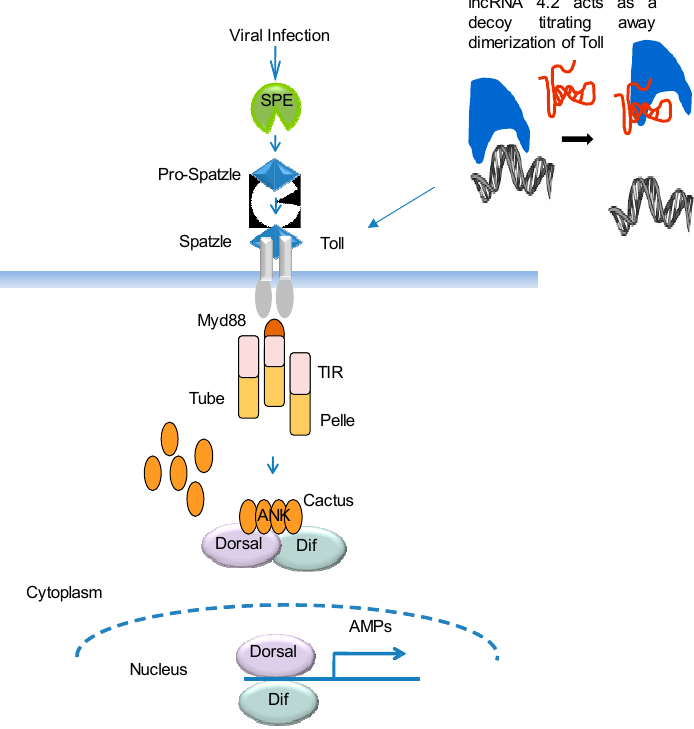
Figure 1. Schematic representation of long non-coding RNA (lncRNA) regulation of immune response pathway. It is hypothesized that lncRNAs can act as a decoy and titrates away dimerization of Toll on the plasma membrane, resulting in dysregulation of the Toll signaling pathway. TIR-Toll/Il-1 receptor domain, SPE – spätzle processing enzyme, ANK- ankyrin repeat domain, AMP- antimicrobial peptides, Dif-nuclear factor-kB like